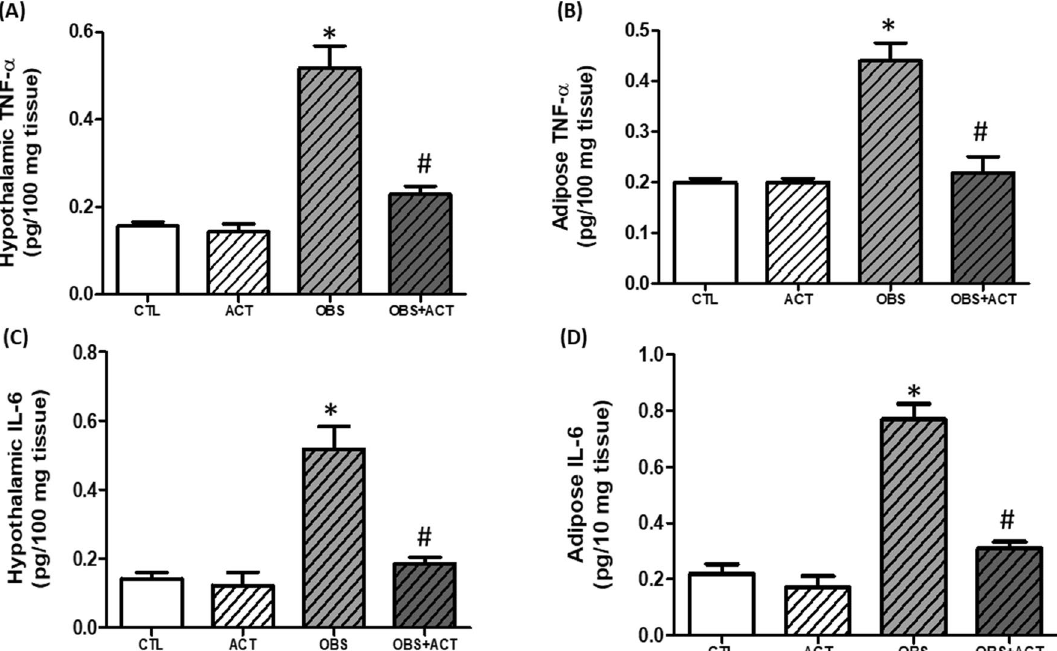
Figure 7. Effects of acetate on hypothalamic and adipose TNF-α ( A – C ) and IL-6 ( D – F ) in high fat diet- induced obese Wistar rats. Hypothalamic and adipose TNF-α and IL-6 increased in obese rats, which were attenuated following the administration of acetate. Data are expressed as mean ± SD. n = 6 and analyzed by one-way ANOVA followed by Bonferroni post hoc test. (* p < 0.05 vs. CTL; # p < 0.05 vs. OBS). CTL Control, OBS Obesity, ACT Acetate, TNF-α Tissue necrosis factor-α, IL-6 Interleukin-6.